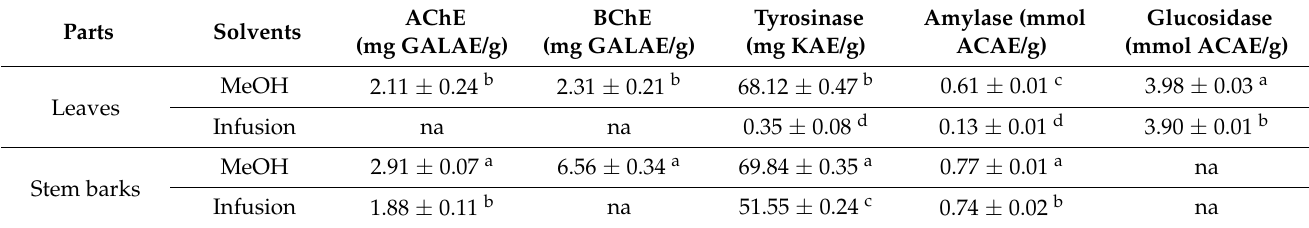
Table 4. Enzyme inhibitory properties of Ficus sur extracts.